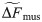
Sensitivity analysis of muscles forces using ΔF~mus.Asterisk: shift in AP direction. Square: shift in CC direction. Circle: shift in LM direction.